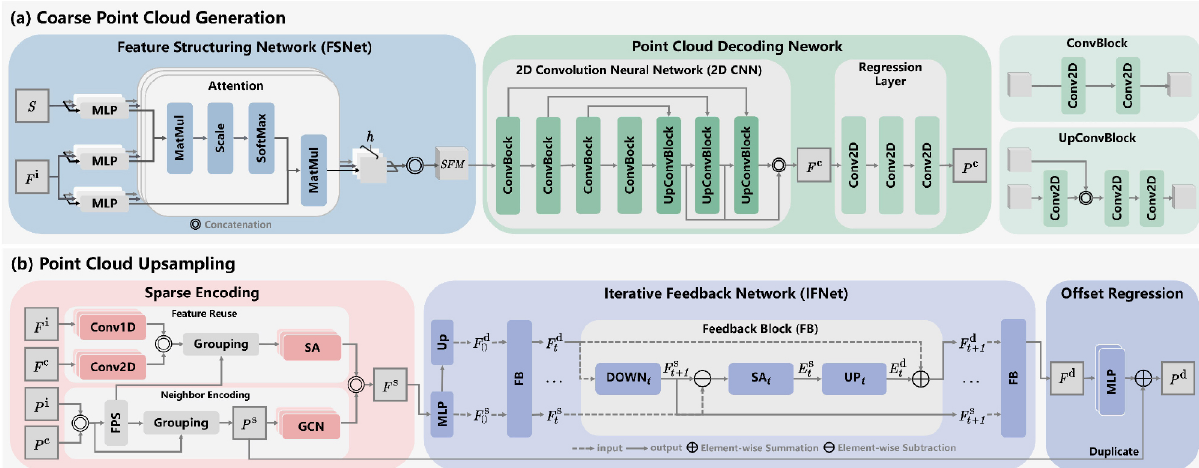
Fig. 3 Network architectures of (a) our coarse point cloud generation module and (b) our point cloud upsampling